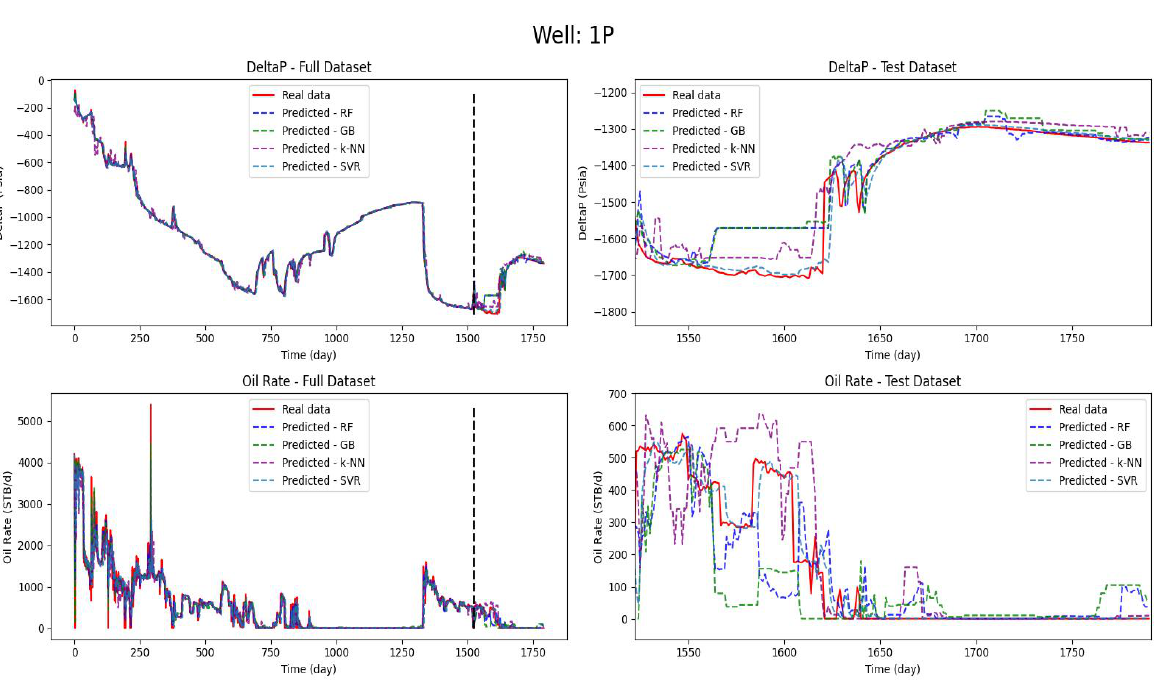
P vs Time - Full Dataset (Top Left);